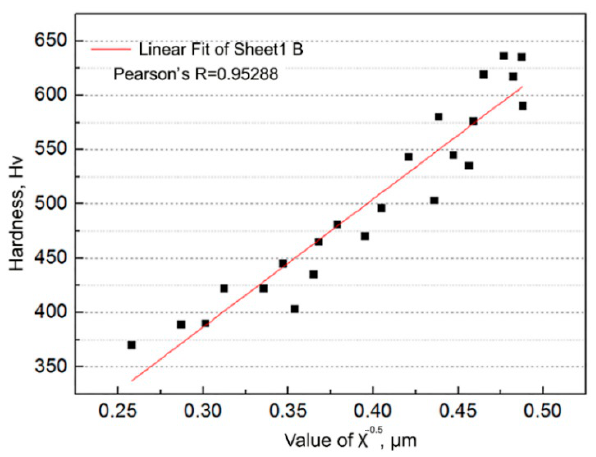
Figure 5. Relationship between hardness of the alloy and value of χ − 0.5 .